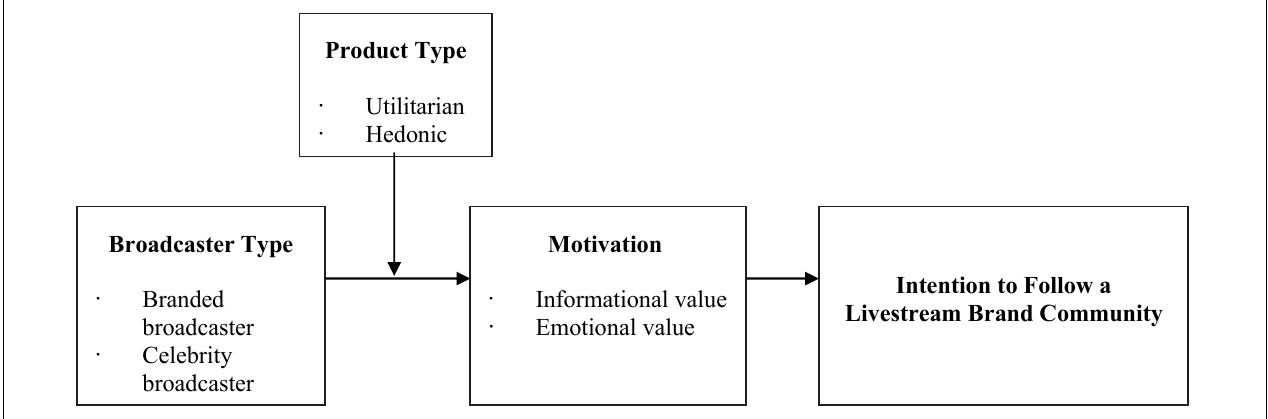
FIGURE 1 | Research